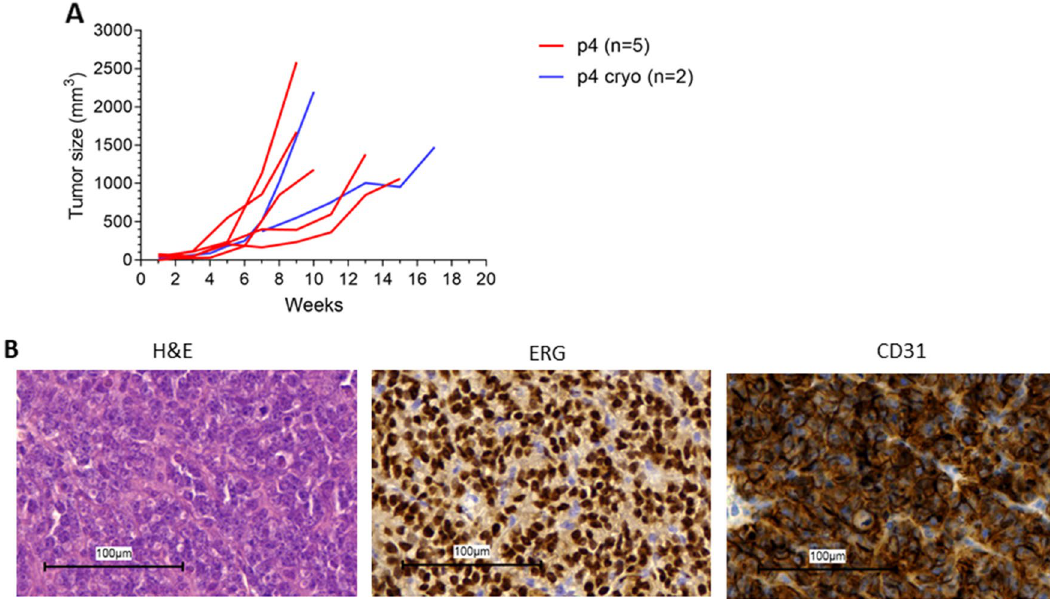
represents a separate tumor. ( B ) H&E, ERG and CD31 staining on cryopreserved PDX